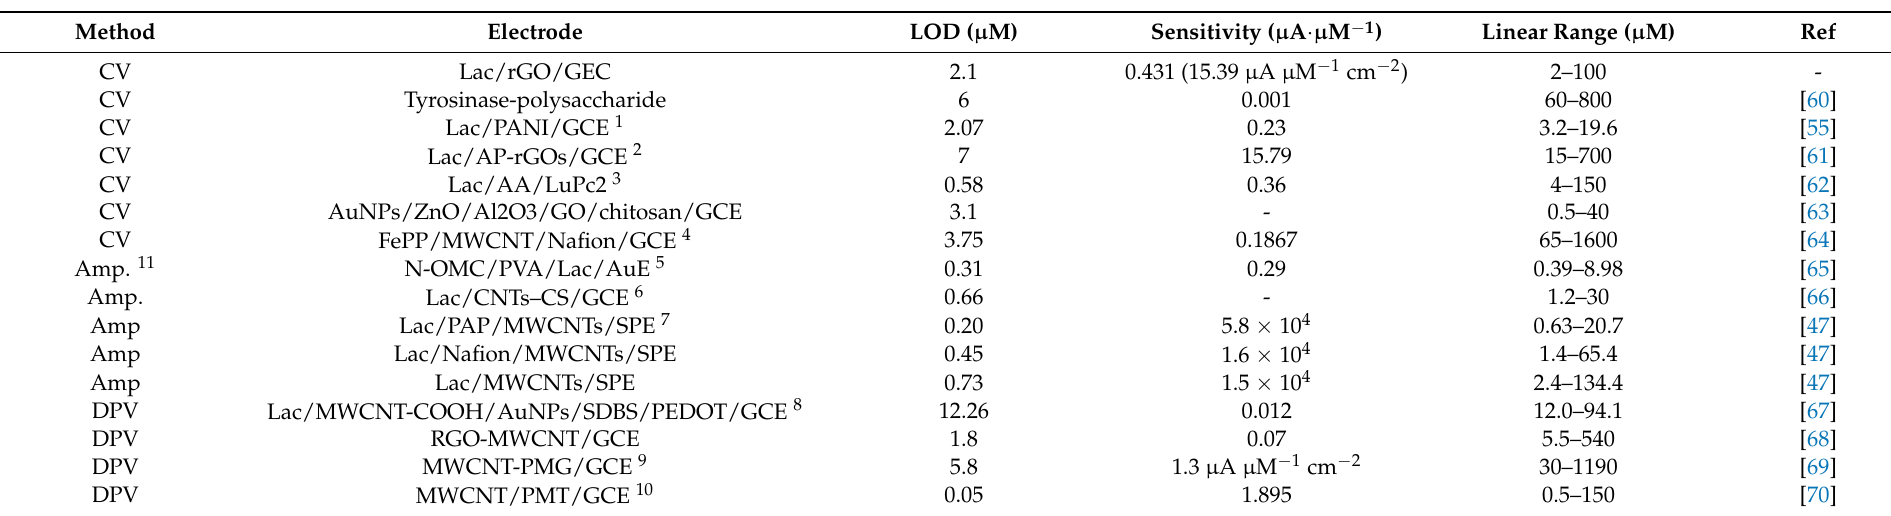
Table 3. Reported values for the analytical study of sensors and biosensors for the quantification of